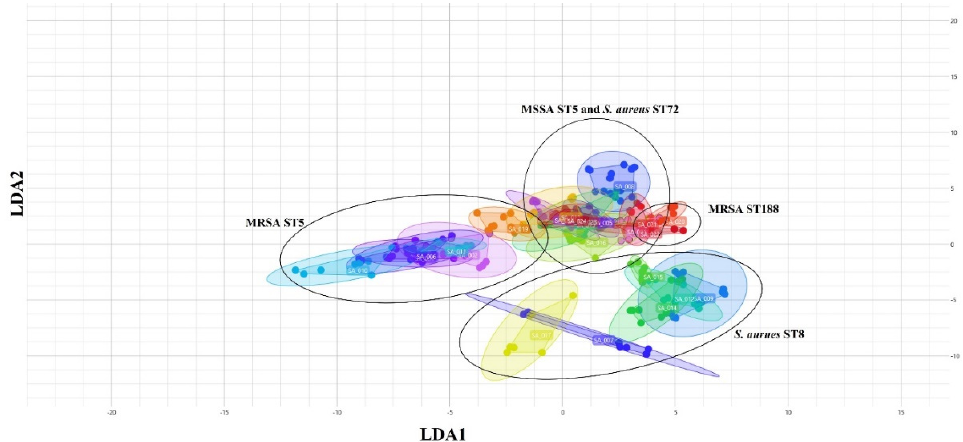
Figure 4. Assessment of 2D scatter plot for 72 spectra of LDA analyses on TSA medium. MRSA ST5 and S. aureus ST8 are separated from MSSA ST5, MRSA ST188, and S. aureus ST72.